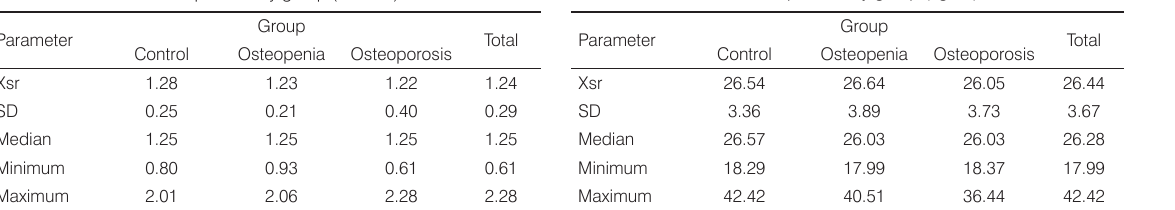
Table 4. BMI values in patients by group (kg/m 2